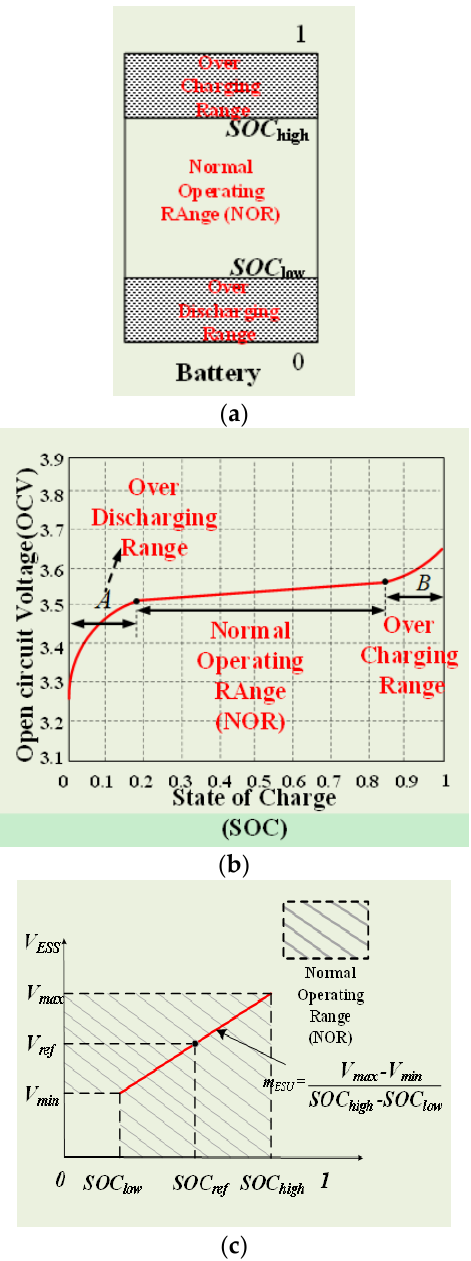
Figure 8. Conditions for stable ESS control. ( a ) Operating regions; ( b ) Characteristic curve of a lithium-ion battery with respect to SOC; ( c ) Schematic diagram for designing an SOC-based droop control strategy.